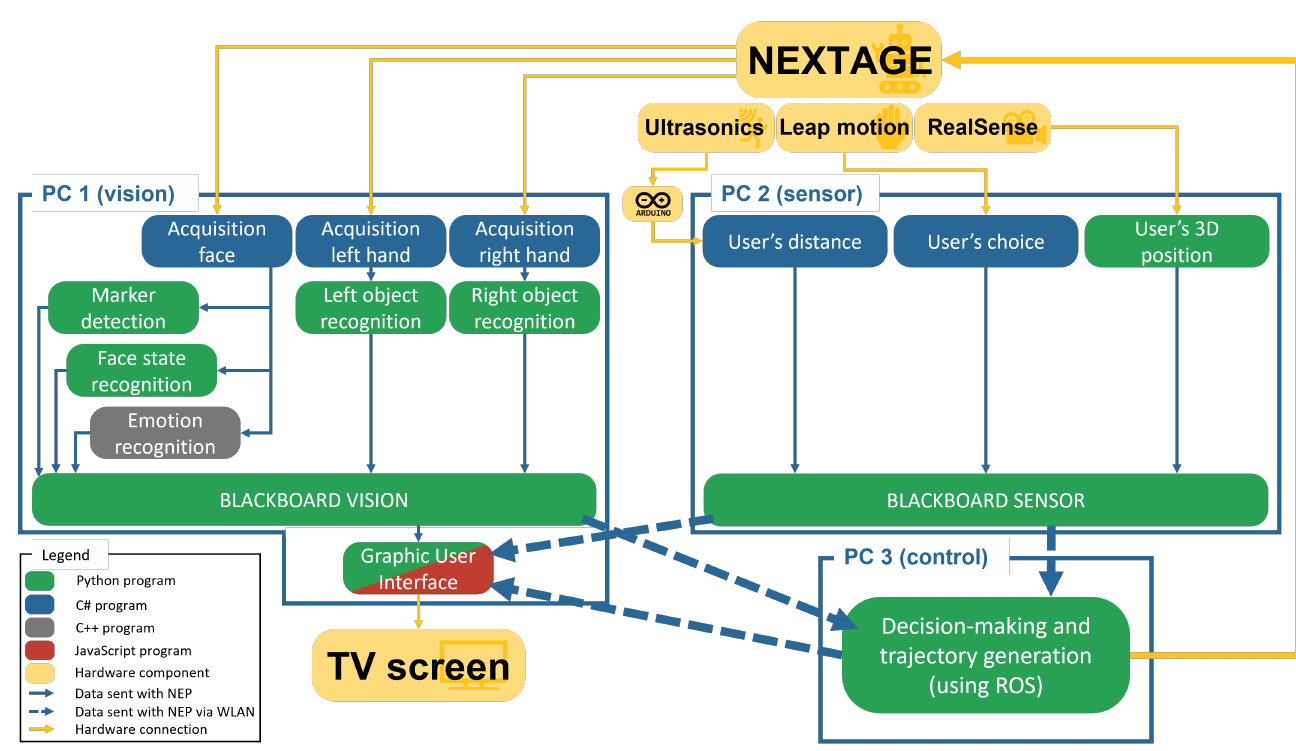
Figure 3. General architecture of the project. The GUI program is using client-server architecture, the server is in Python and the client in